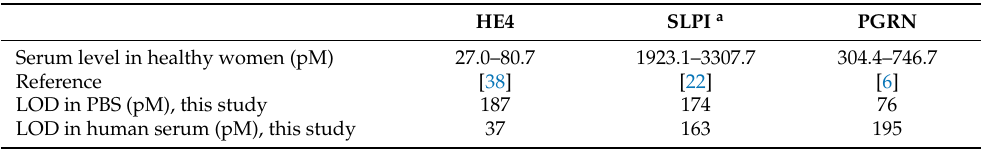
Table 5. Comparison between the serum levels in healthy women and the obtained limits of detection (LOD) for the recombinant human HE4, SLPI, and PGRN antigens by the selected nanobodies HE4-6, SLPI-1, and PGRN-5,